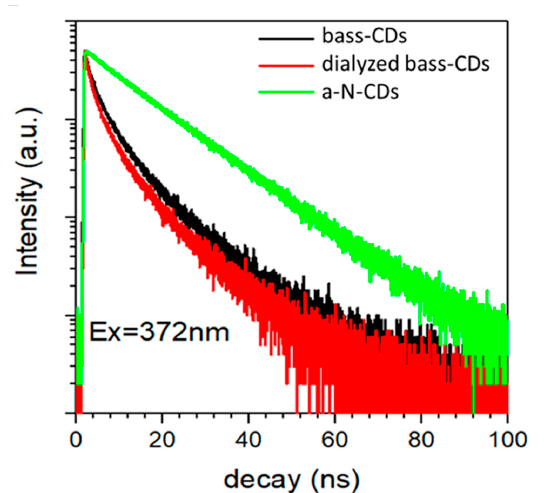
Figure 4. Time-resolved PL measurements of a-N-CDs (green), bass-CDs (black) and dialyzed bass-CDs (red). bass-CDs